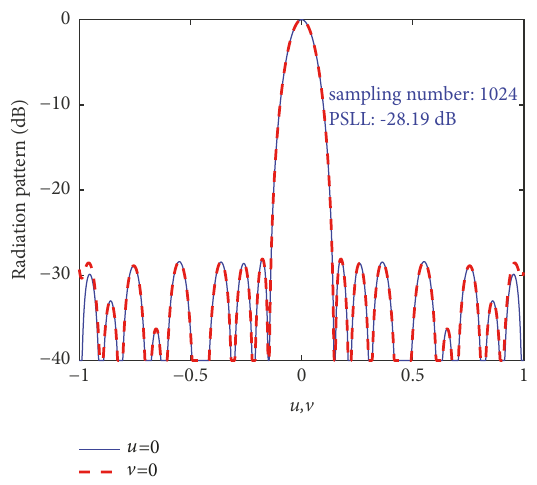
Figure 10: The cut of radiation pattern 𝑢 = 0, V = 0.